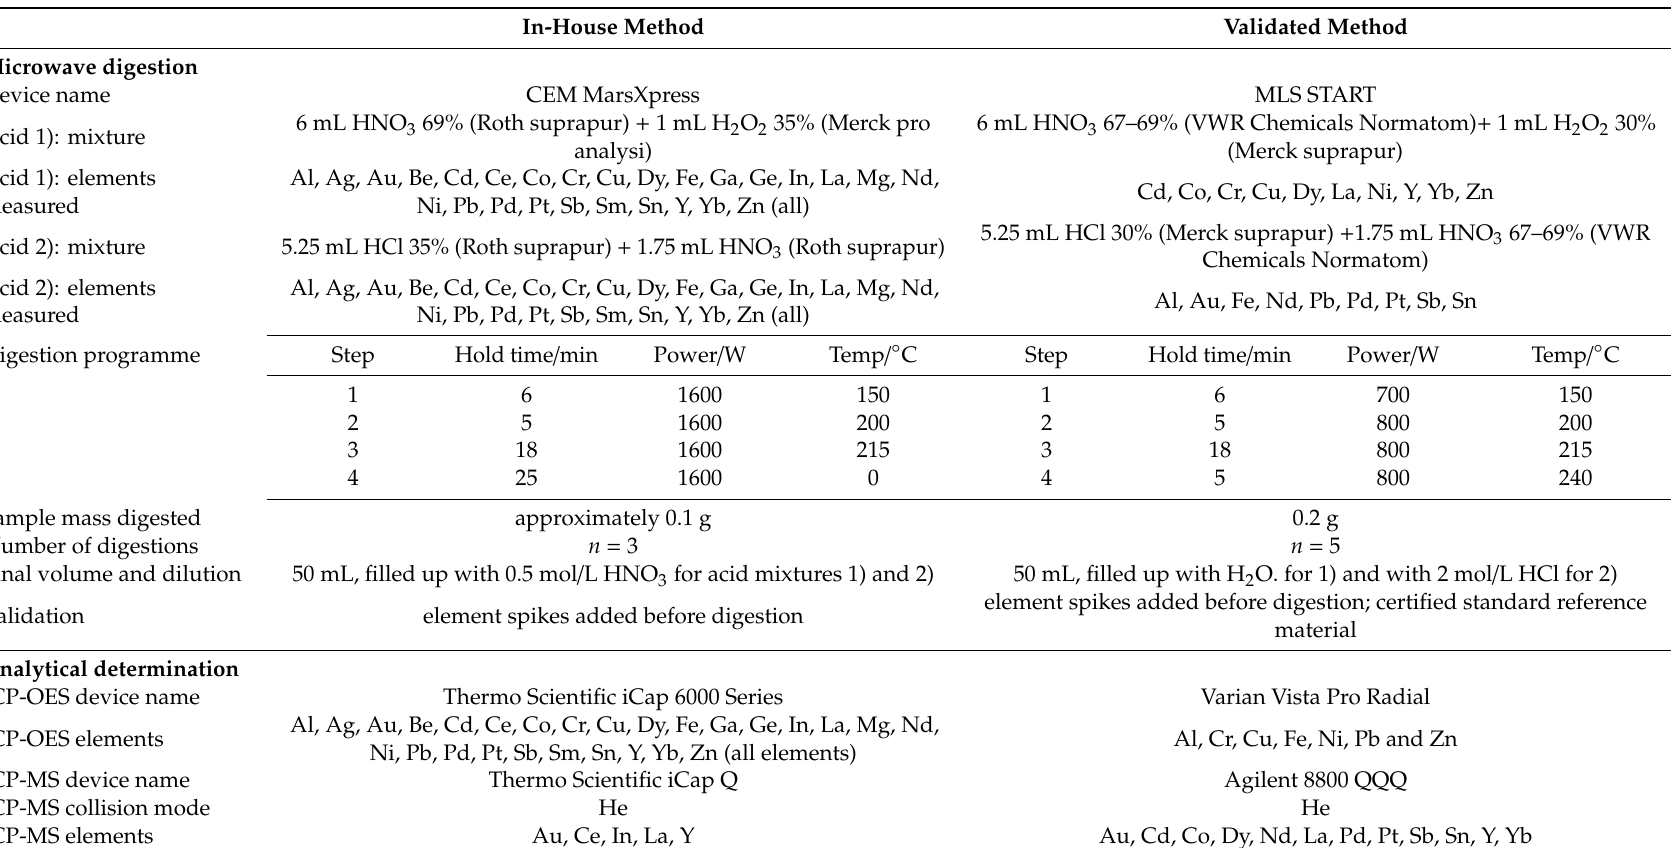
Table 3. Wet-chemical analysis